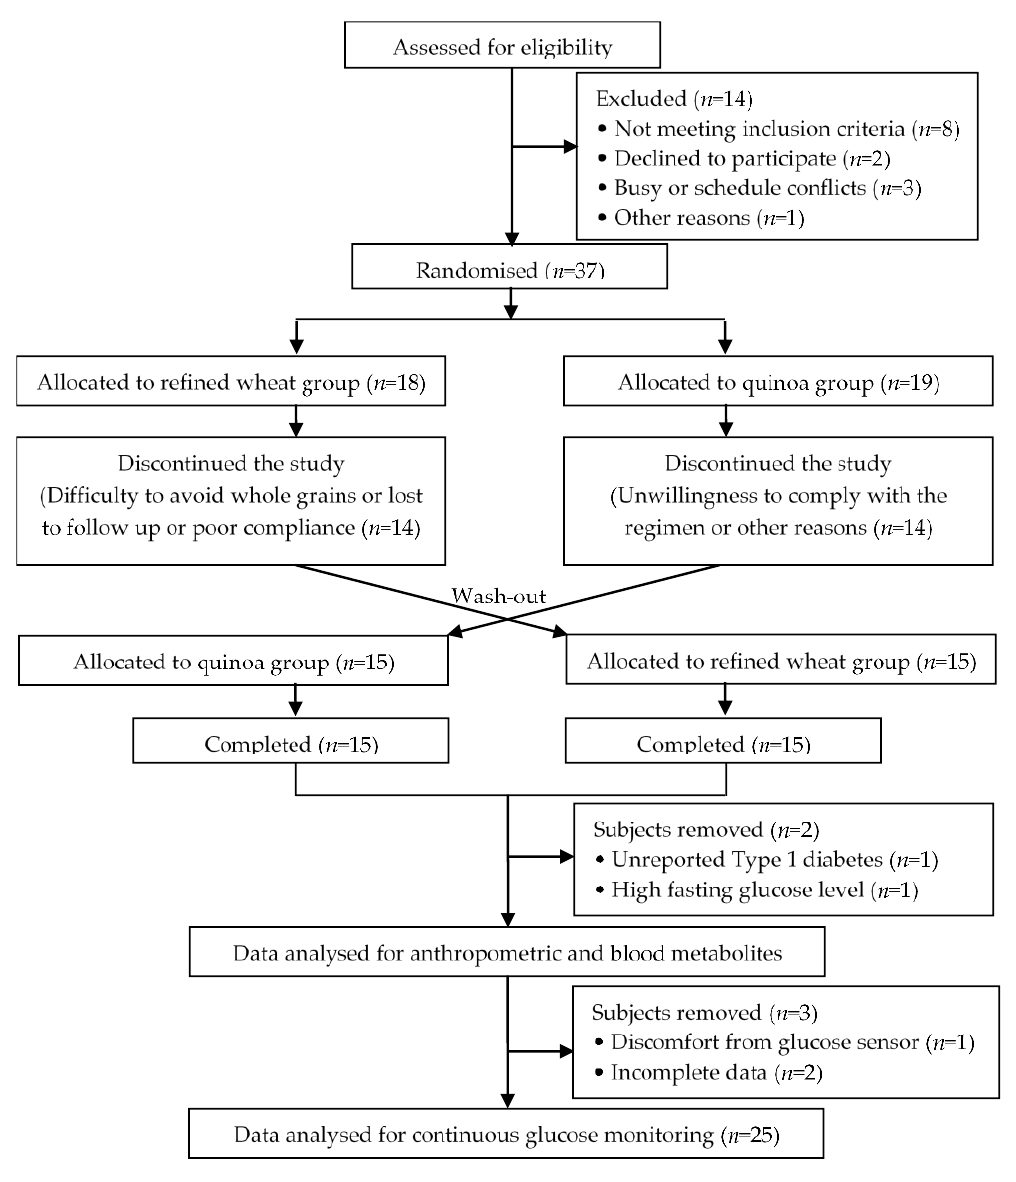
Figure 1. Flow diagram of enrolment, treatment allocation, withdrawals and follow-up of participants through the trial.